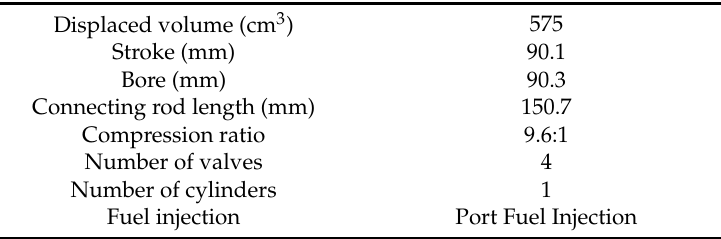
Table 2. Engine specifications.